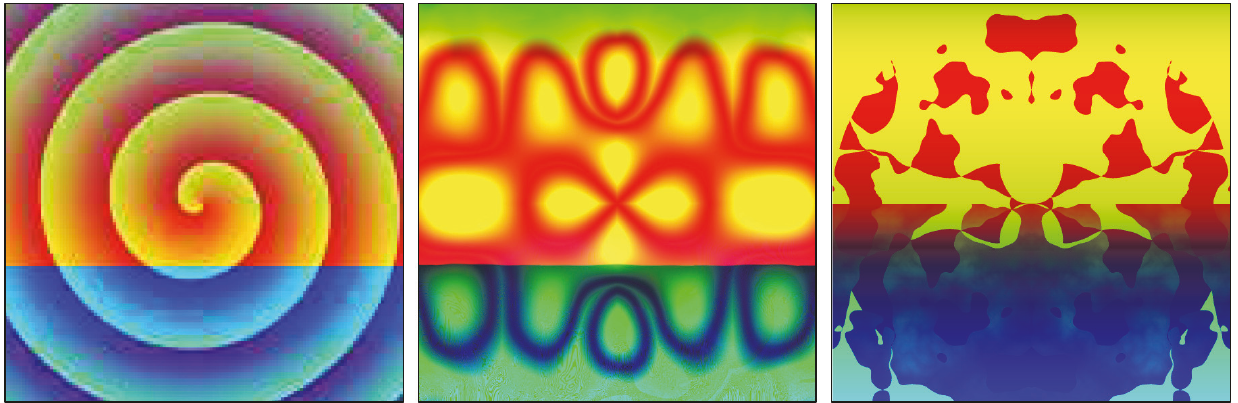
Figure 14: Colour experiment highlights; Composition 13; noise language. The leftmost image shows the target, followed by a pair of notable evolved